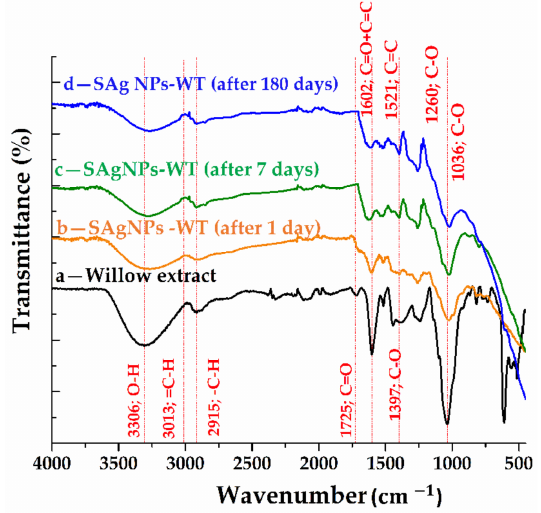
Figure 5. ATR-FTIR spectra for (a) willow extract and silver nanoparticles, (b) 1 day, (c) 7 days and (d) 180 days from